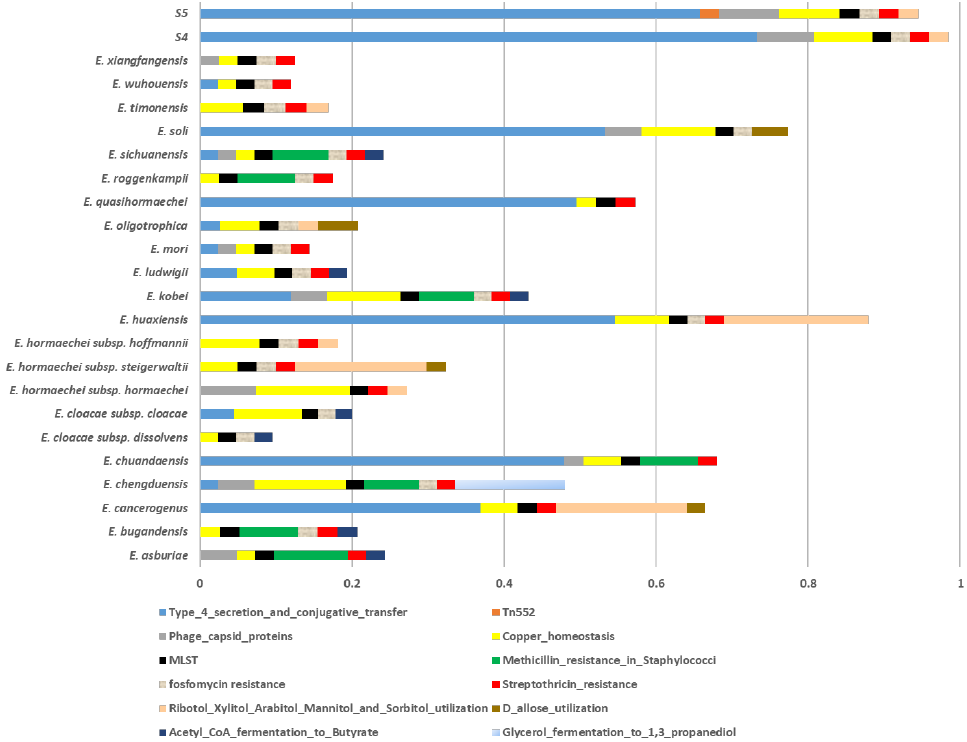
Figure 5. Distribution of a selected SEED domain categories between the isolates (S4, S5) and the representatives of all validly published Enterobacter species (see Materials and Methods for full species list and accession numbers). Interestingly, isolates S4 and S5 have the largest proportion of Type 4 Secretion System in addition to being the only genomes carrying Tn522.